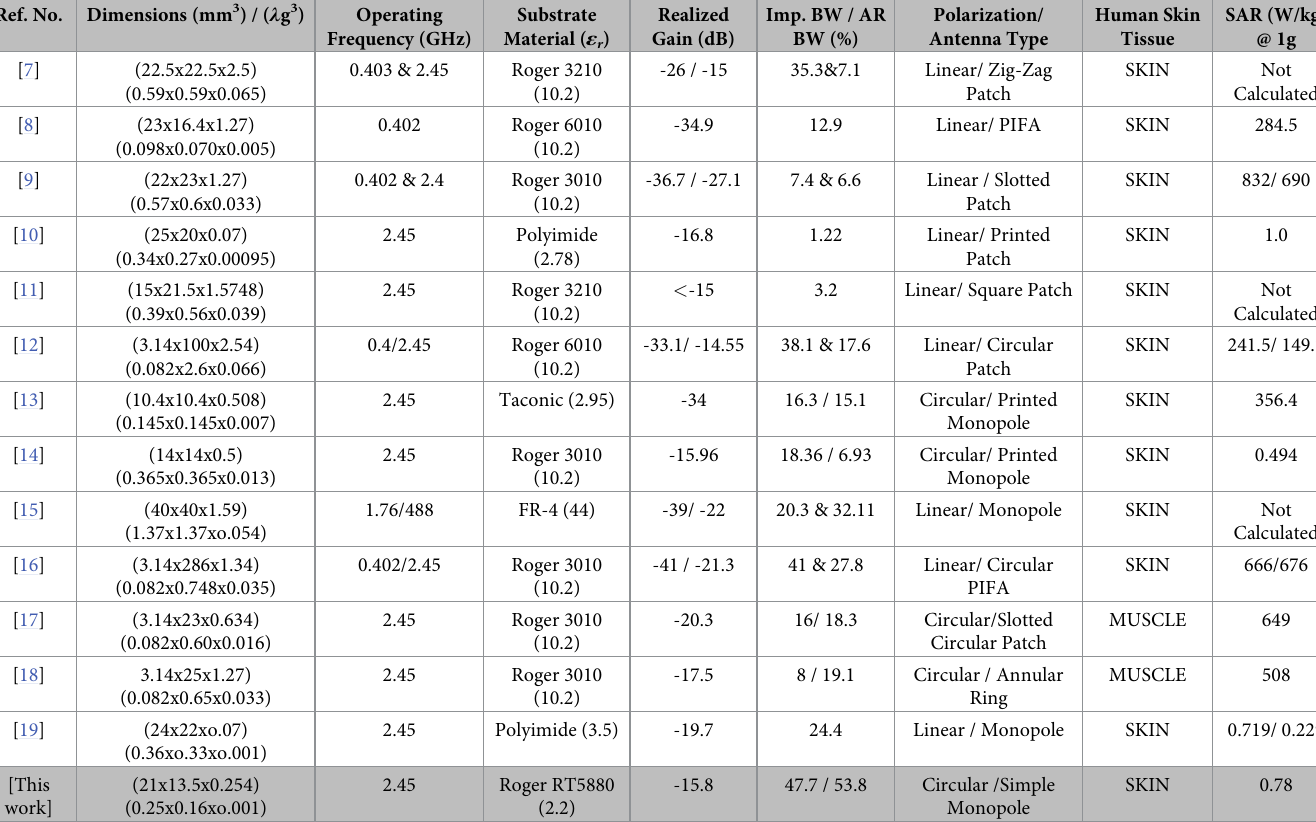
Table 1. Performance comparison of the proposed antenna with recent work. Ref. No. Dimensions (mm 3 ) / ( λ g 3